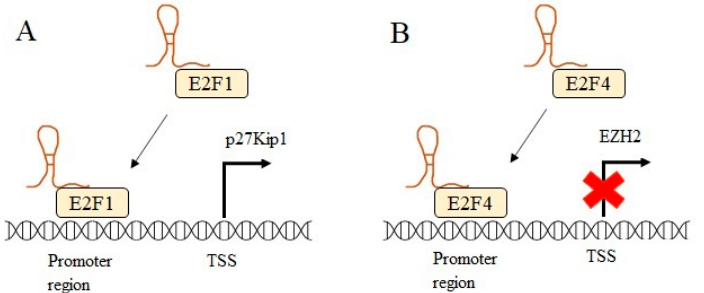
Figure 4. GAS5 acts as a guide by directing transcription factors to the promoter region of the gene.